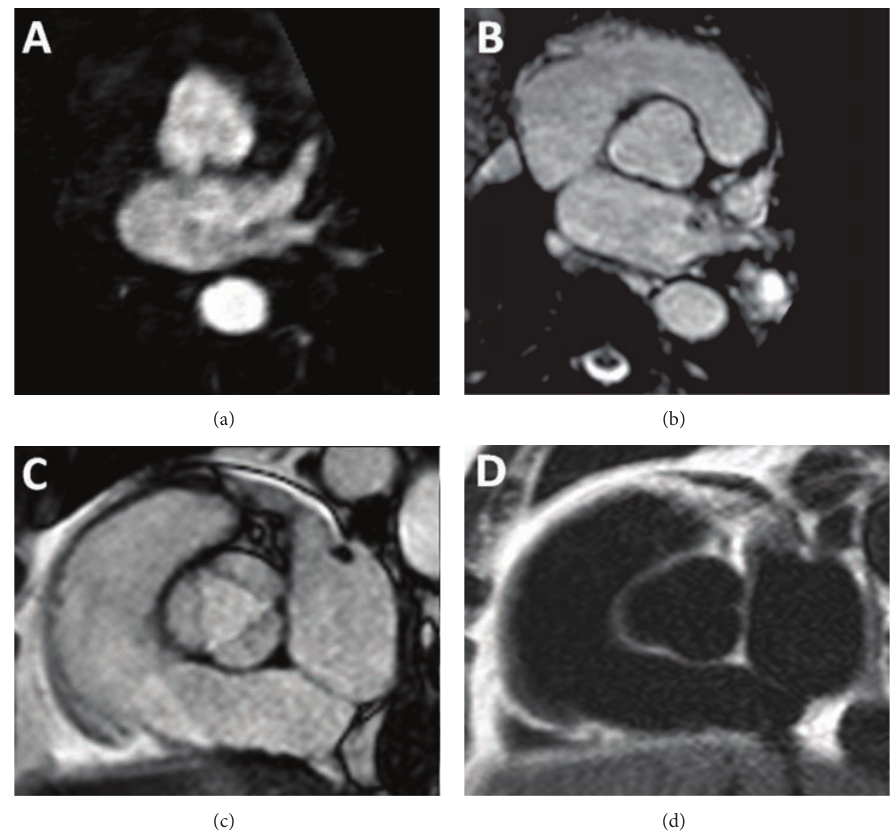
Figure 3: Measurement of the aortic size in various MRI sequences; (a) 3D contrast enhanced MR angiography. The margins are blurred since the acquisition is not ECG gated. (b) Noncontrast 3D steady state free precession (SSFP) image has sharp margins due to ECG gating. (c) 2D SSFP cine image, which can be acquired throughout cardiac cycle, enabling measurement in systole or diastole. (d) T2-weighted black blood image, which is also acquired with ECG gating.